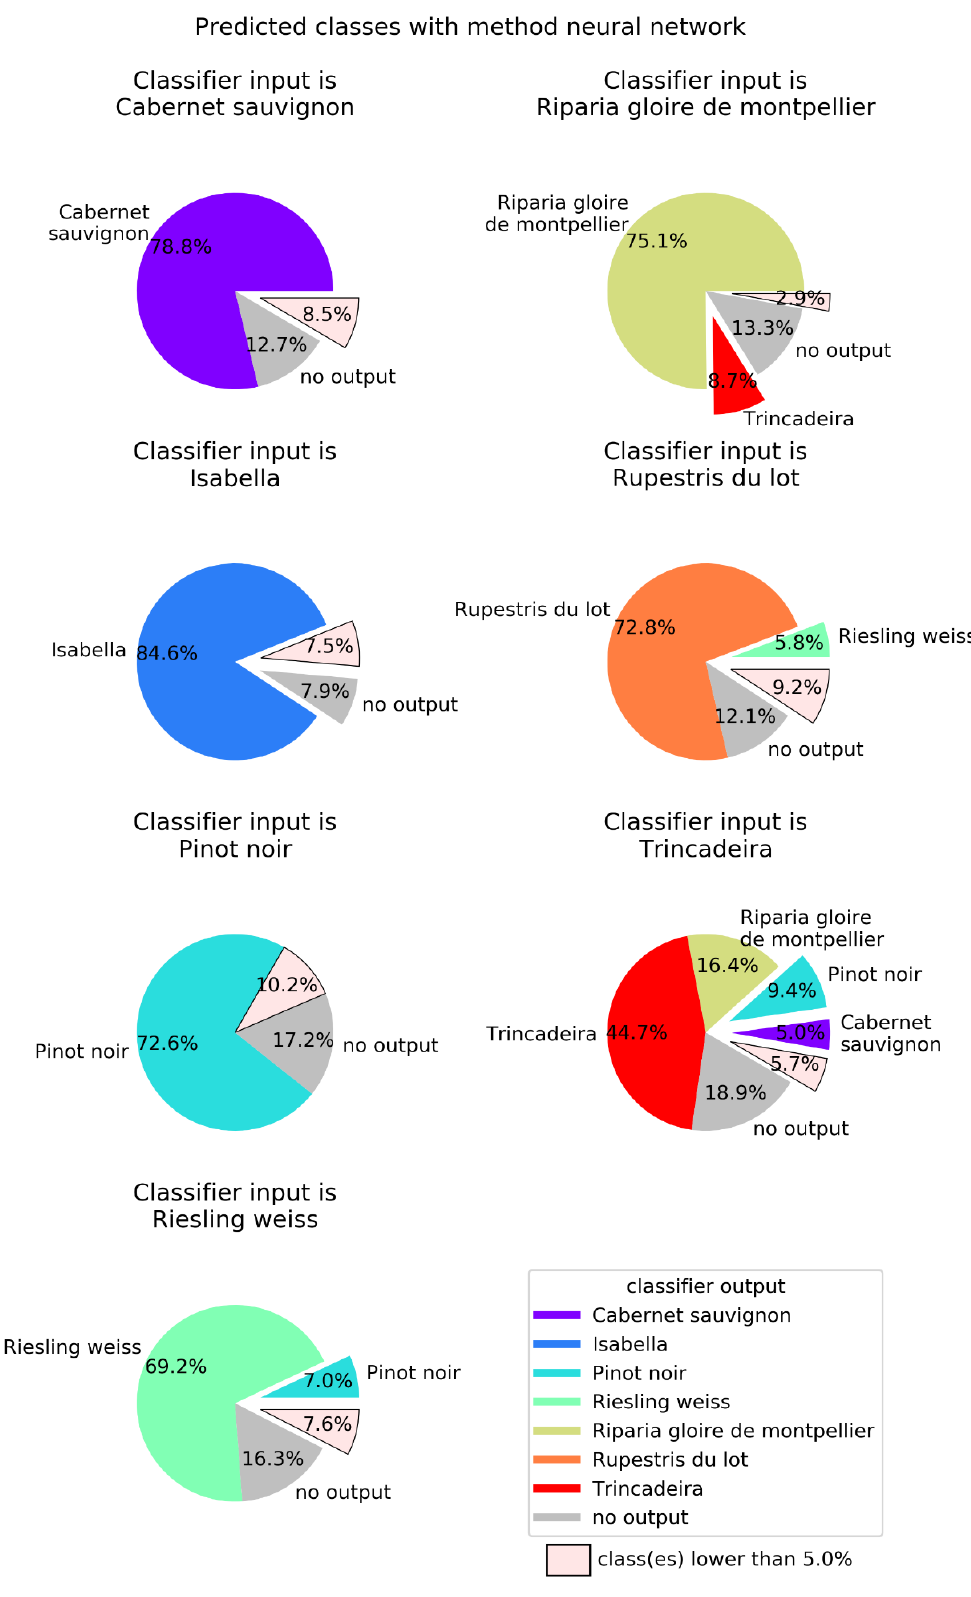
Figure 6. Neural networks (NN) output for each of the seven possible inputs. NN were defined with 5000 neurons, a single hidden layer, and the neurons in the hidden layer used the logistic activation function. Global success rate is 71.8%.